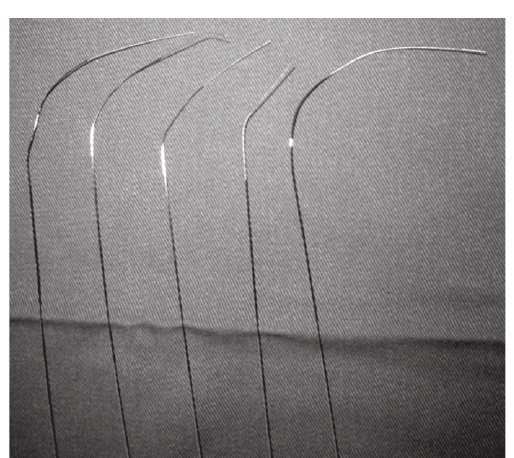
Fig. 2 - Guias com diferentes formatações (curvas com diferentes tamanhos e formas) para se adequar às variações em tamanho e anatomia dos átrios.